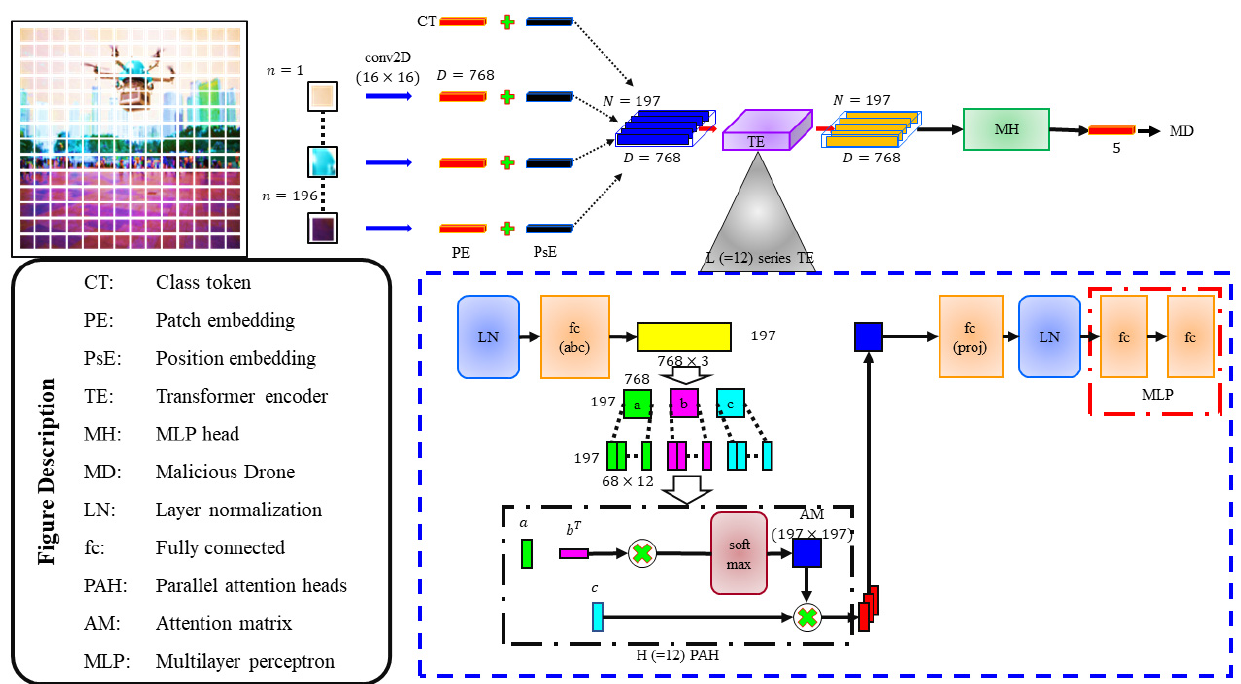
Figure 3. Schematic diagram of the ViT classifier.